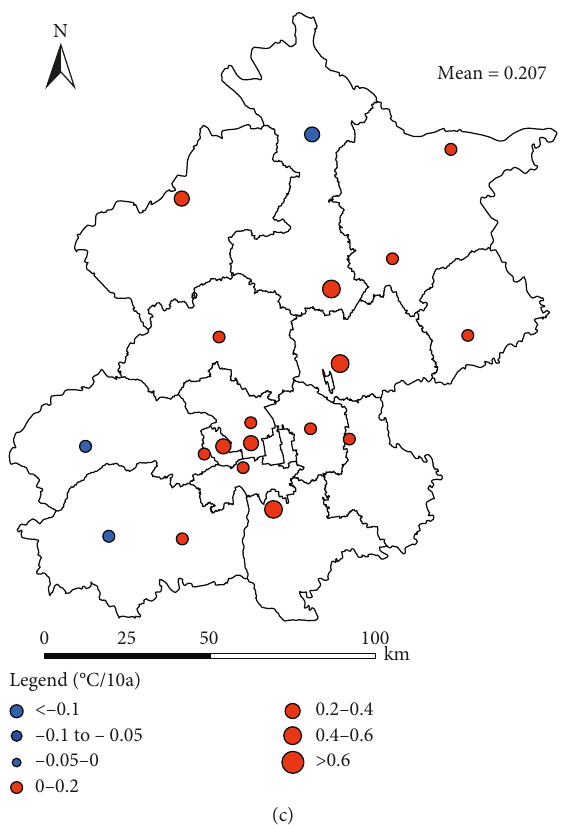
Figure 7: OMR (c) annual mean temperature trends in Beijing from 1979 to